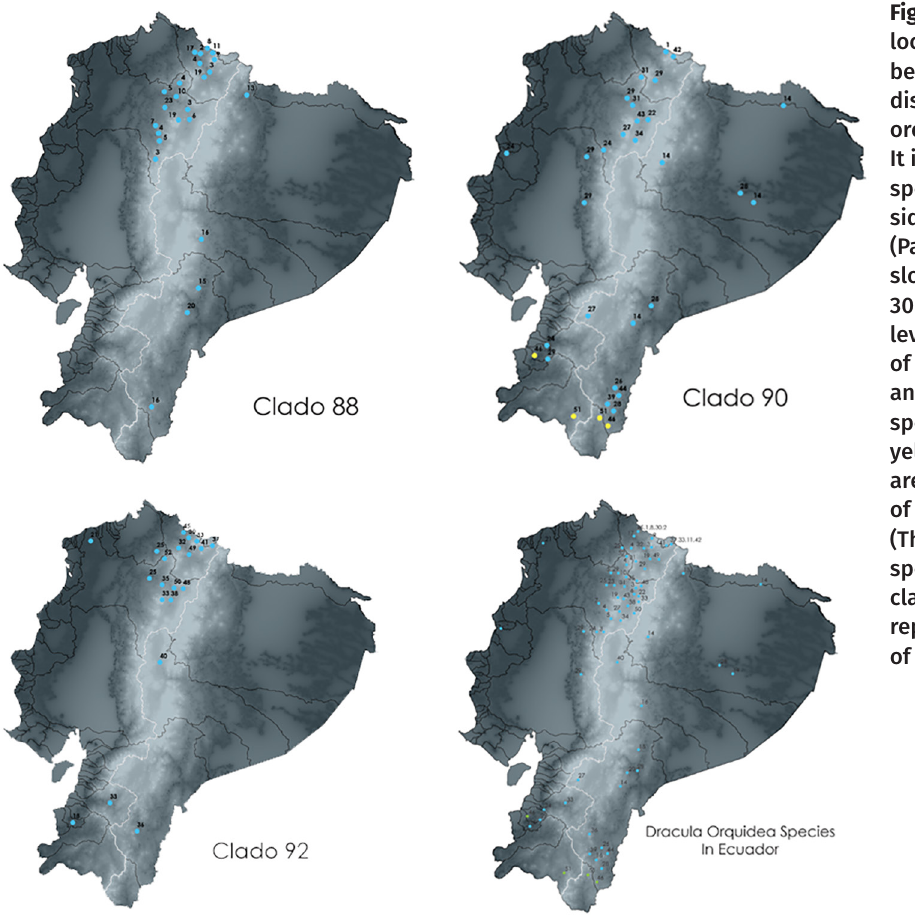
Figure 1. Geographical location of the species belonging to the clade and distribution of